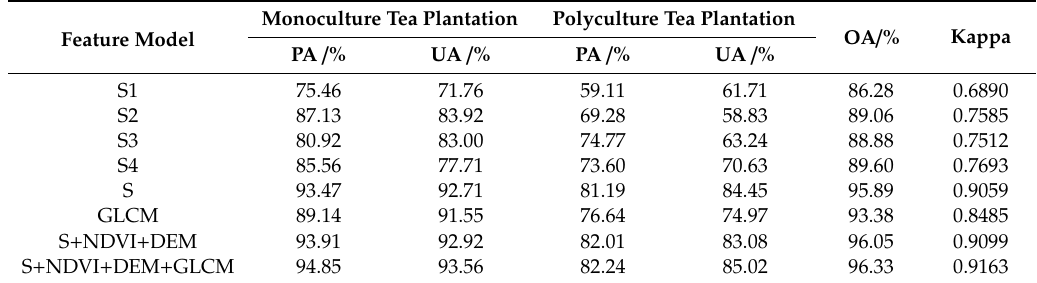
Table 3. Comparison of classification accuracy of di ff erent feature models using the RF method.